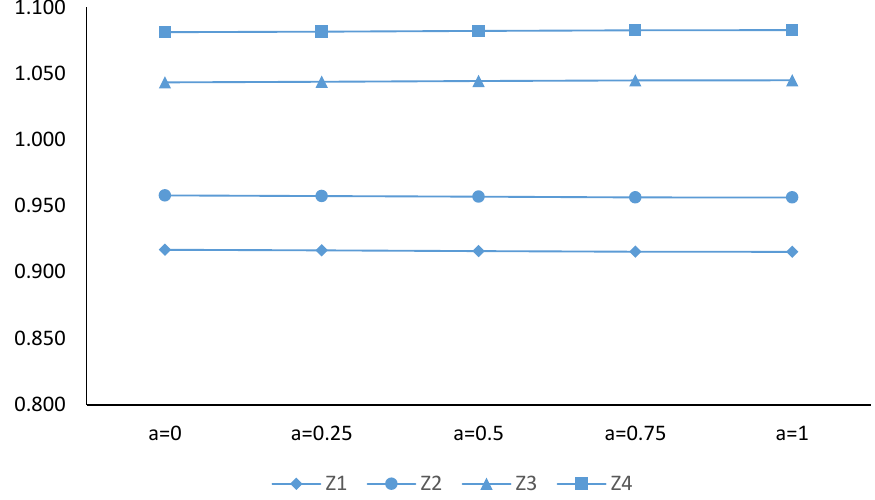
Figure 6. The average difference for each acceptance degrees.